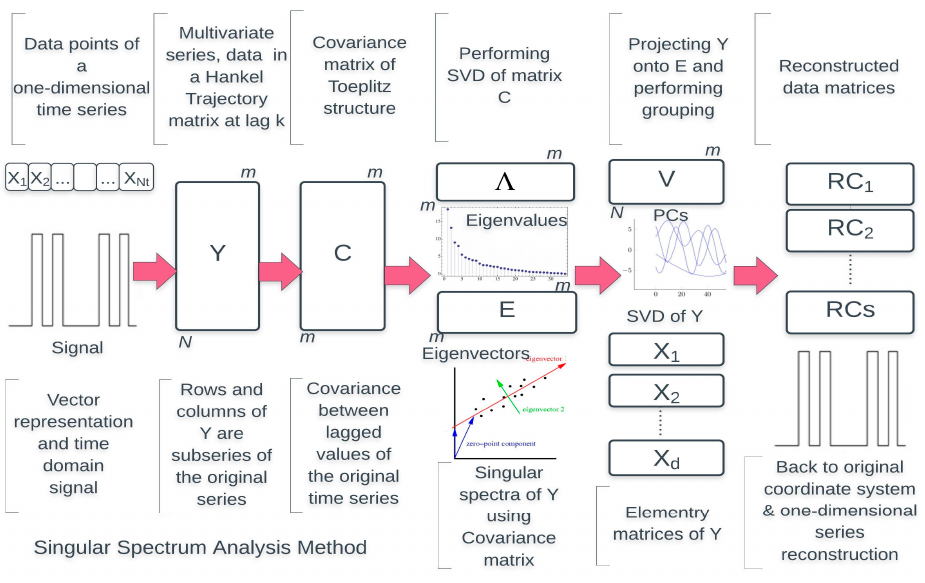
Figure 2. A descriptive process of the SSA method.